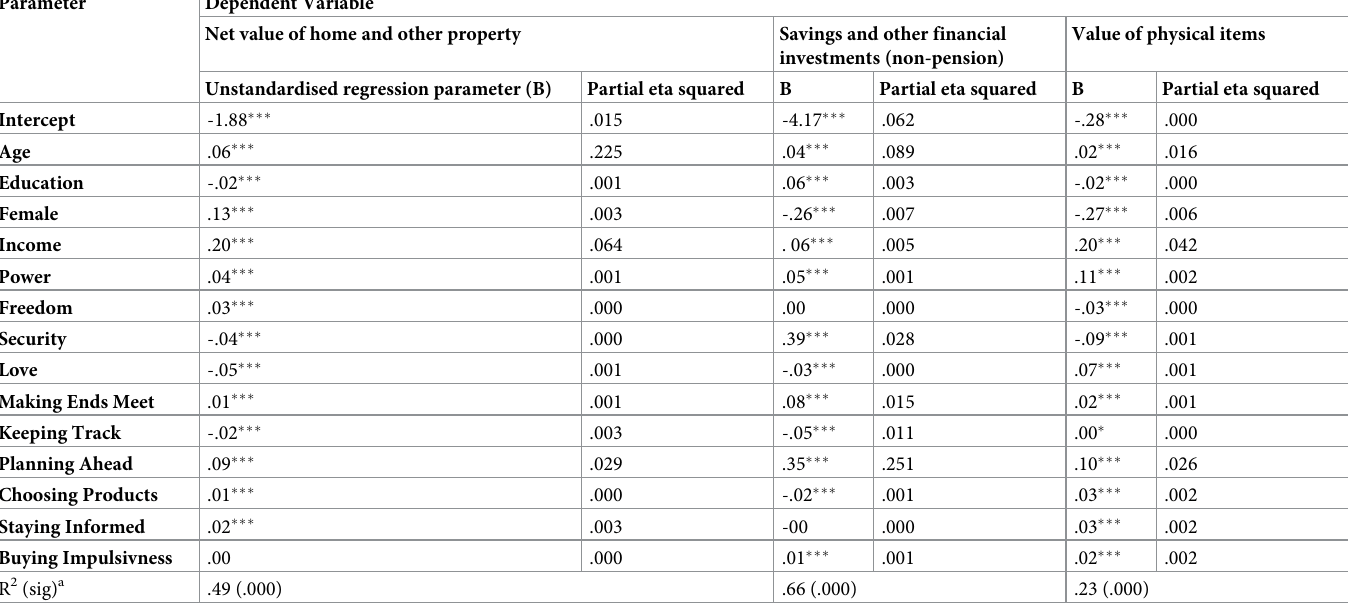
Table 3. Multivariate multiple regression parameters for each wealth measure. Parameter Dependent Variable Net value of home and other property Savings and other financial